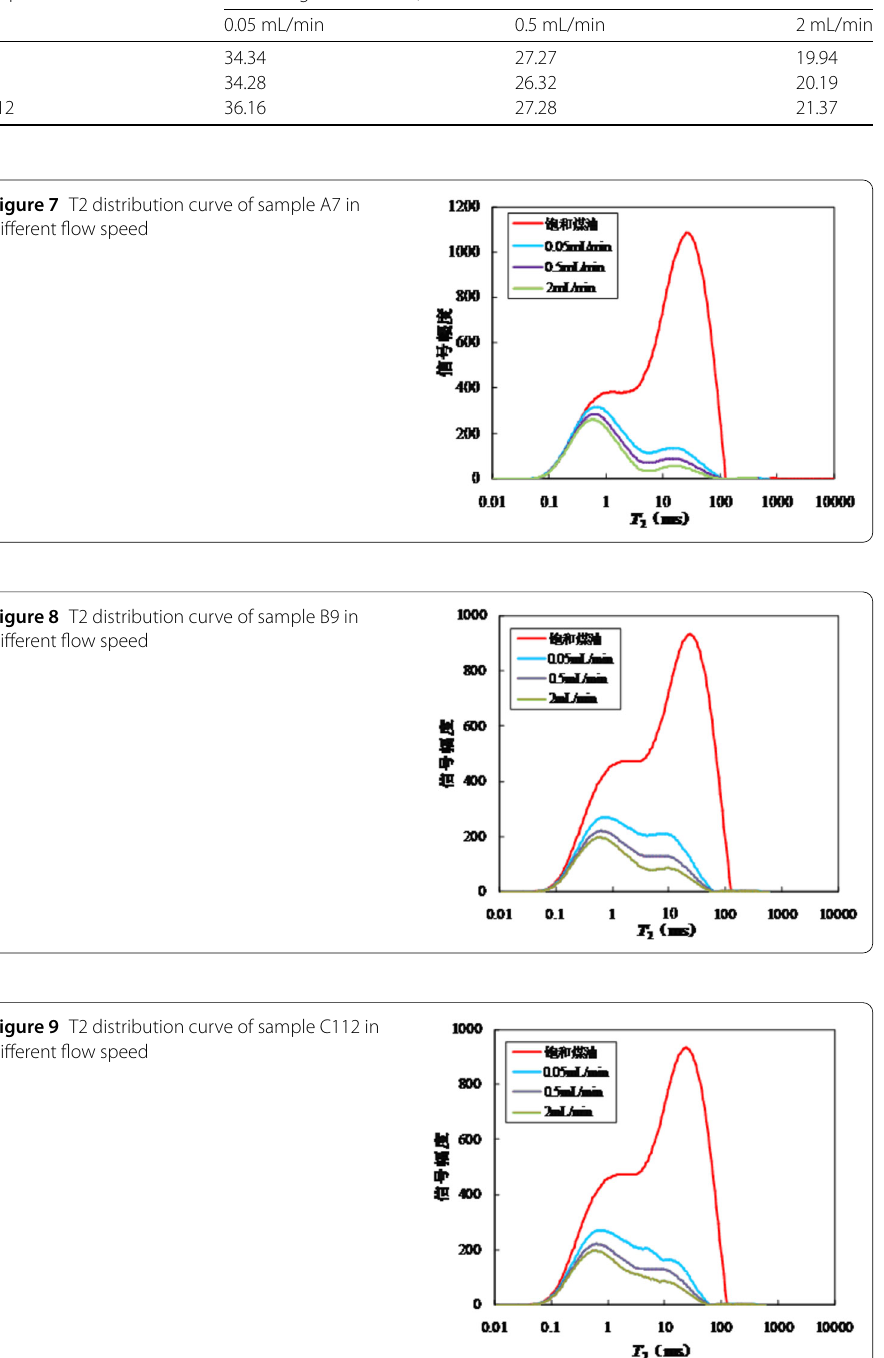
Figure 9 T2 distribution curve of sample C112 in different flow